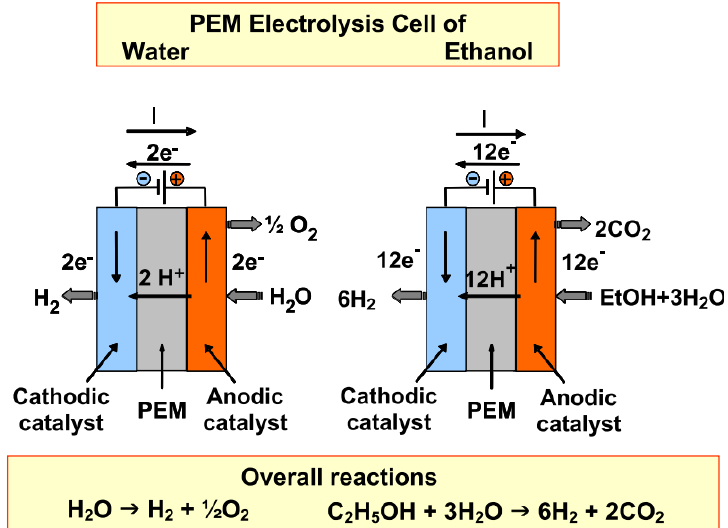
Figure 3. Scheme for PEMEL, proton exchange membrane electrolysis [22,23]. Reprinted with permission from [22].